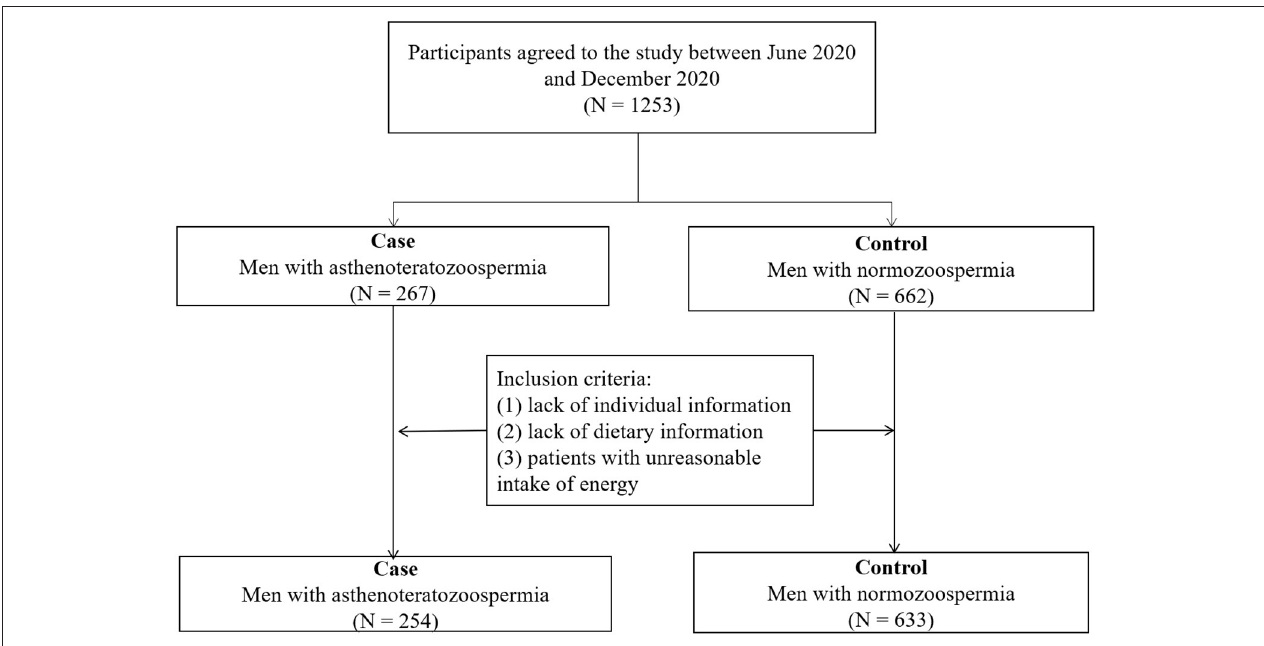
FIGURE 1 | Flow chart of